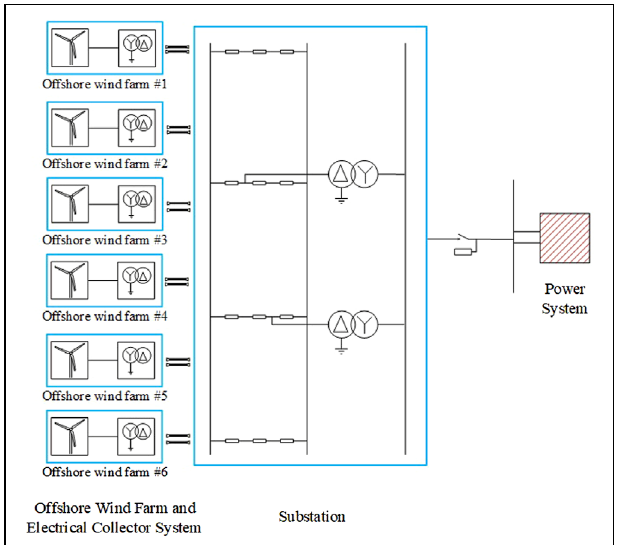
FIGURE 1 | Schematic diagram of offshore wind power